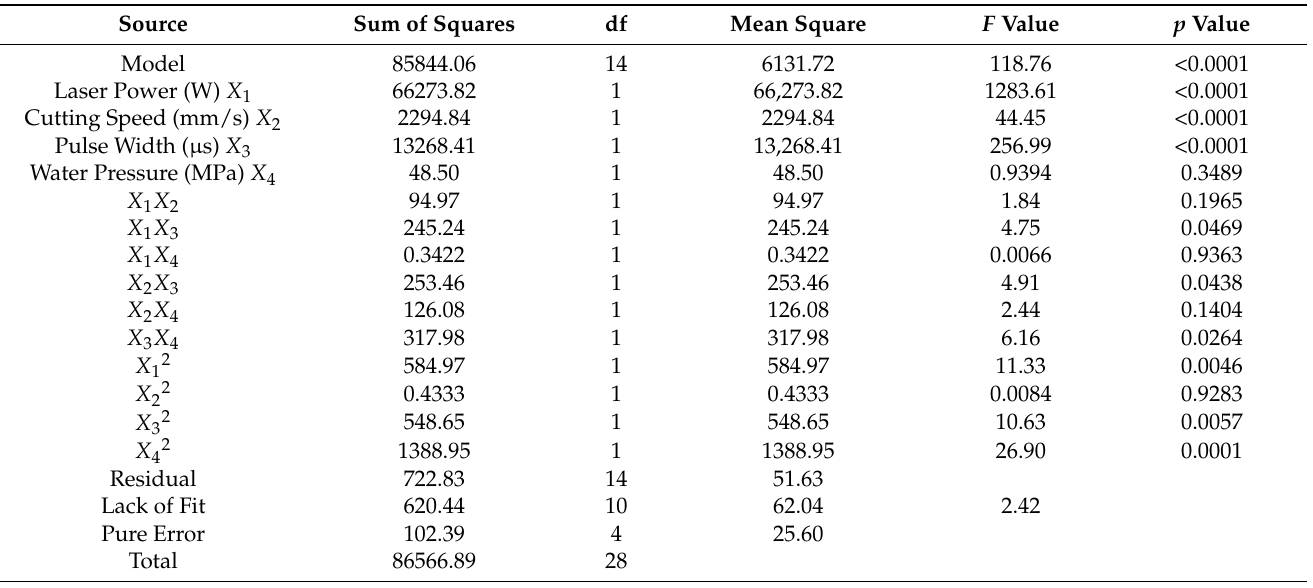
Table 8. ANOVA of the regression model for depth.